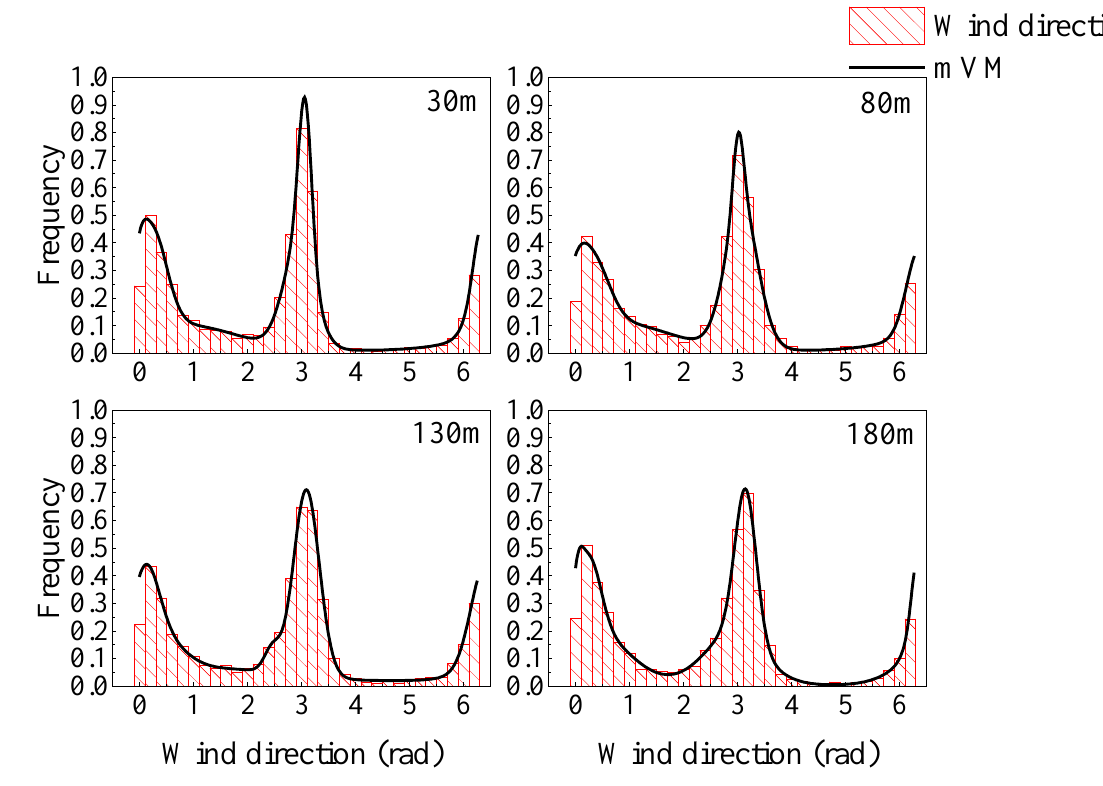
Figure 4. Results of the fitting of wind. Table 7. Parameter fitting value of g ( ζ )